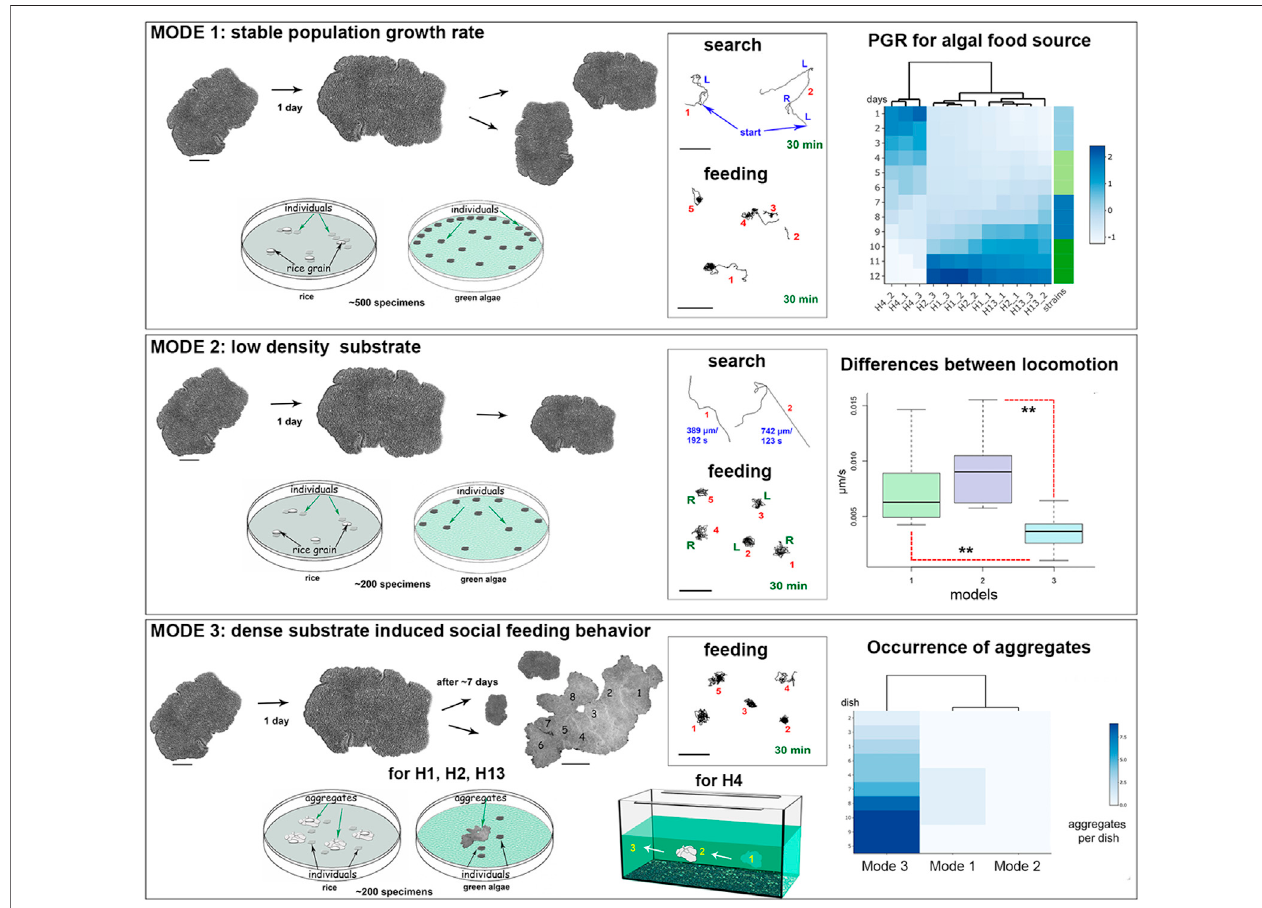
FIGURE3| Threeseparatemodelschemesoflong-termculturing/agingofPlacozoa.Mode1 — optimizedconditions;Mode2 — lowandMode3 — highdensitiesof the green algamat ( Tetraselmis marina ) orrice grains; see textfor details. Mode 1: Optimized culture conditionswith dispersal animals and their moderate concentration onfeedingsubstrates.Themiddlediagramshowsexamplesofexploratoryandfeedinglocomotionfor fi veanimals(numbers)within30 min.Therightdiagramshowsthe representativedynamicsofthepopulationgrowthrate(PGR)forallhaplotypes(H1,H2,H4,andH13).3separatedisheswereusedforeachhaplotype (e.g.,H4_1, H4_2, H4_3, etc.), starting with 10 animals per dish. All datasets were normalized to absorb the variation between columns for all four haplotypes of Placozoa. Under these conditions, animals steadily increase their body surface area and have vegetative (non-sexual) reproduction by fi ssion. Mode 2: Low-density substrate. Limit of food source led to decreasing ofanimal sizesand numbers of animals in culture dishes. Mode 3: High-density substrate. There isboth increasing inanimalsizes and the aggregationof2 – 15individualsaroundricegrainsoronthedensealgalmat.Theheatdiagramontherightshowsthepredominantoccurrenceofaggregatescompared to Mode 1 (no aggregates were observed on low-density substrates in Mode 2). H4 expressed the same behavior patterns on the walls of 20L aquarium, where individuals within the aggregate could move together (1-2-3, arrows). However, most animals stay at the substrate (central diagram) with signi fi cantly reduced overall locomotion during the feeding, as indicated in the right middle diagram. Each set of video images (Mode 1 – 3) was analyzed using ImageJ (NIH), calculating for velocity, animal area, and perimeter ( n = 3 – 6), as was reported elsewhere (Romanova et al., 2020a). Difference between locomotion in Modes 1 and 3: p -value is 0.003002; between Modes 2 and 3: p -value is 0.000072 (unpaired Student ’ s test). Scale bars: for individual animals — 200 μ m; for the aggregate in Mode 3 — 1 mm; for all locomotory tracks — 200